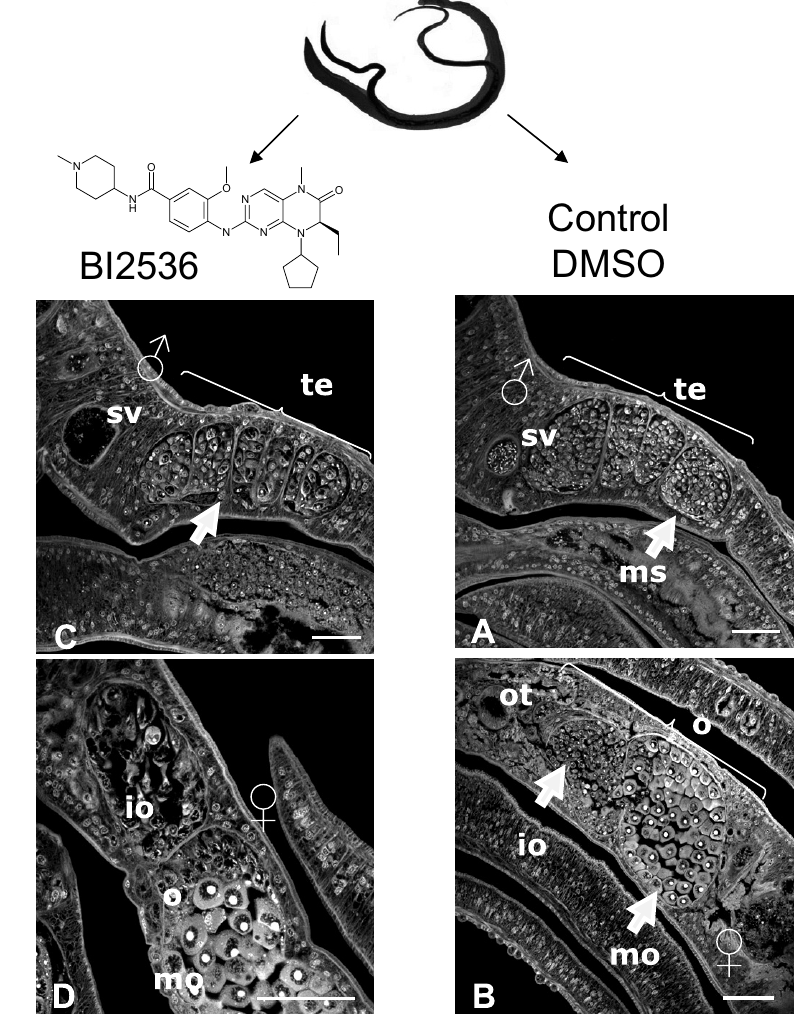
Fig. 3 – In vitro effect of BI 2536 on the morphology of schistosomes . Paired adult worms were cultured in vitro without or with BI 2536 (100 nM) for 7 days, then examined by confocal laser scanning microscopy (Long et al. 2010). In untreated male parasites, testes (te) are full of spermatocytes, and the sperm vesicle (SV) is full of sperm. In untreated female worms, we can observe immature (io) and mature (mo) oocytes contained in the ovary as well as the ootype (ot). In male worms, BI 2536 induces a diminution of the production of spermatocytes in testes, and in the sperm vesicle no more sperm is detected. In treated-females, BI 2536 affects the production of oocytes. Immature oocytes are less numerous and exhibit important morphological changes. These results indicate that the drug affects gametogenesis both in male and female